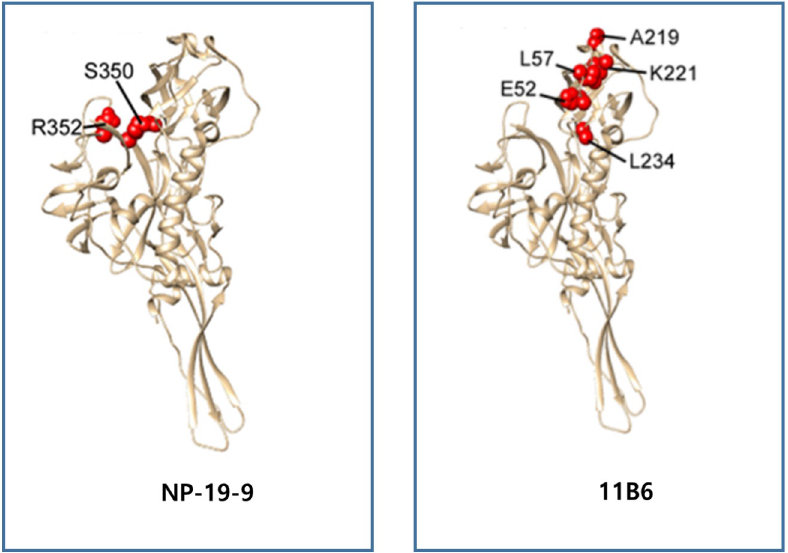
found globally. For focal characterization of neutralizing activity of NP-19-9 and 11B6 to pre- viously tested viruses, in vitro RFFIT test were conducted with an endpoint study. The results of the test are shown in Table 5. Overall, NP-19-9 antibody showed high neutralization activity across tested viruses. 11B6 showed slightly higher neutralization against bat viruses in Mexico, Brazil and the USA (i.e., Washington State). Rabies-related lyssaviruses from Africa, Australia and Europe were also neutralized by both mAbs.